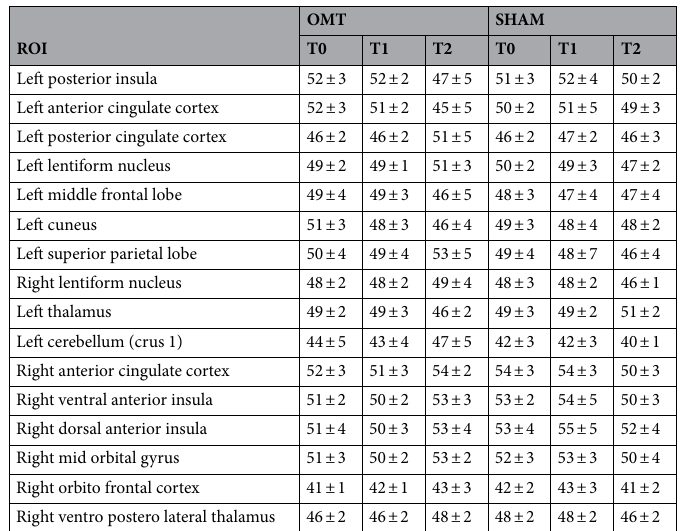
Table 2. rCBF values. Regional CBF values on region of interests (ROI) in both study groups at different time points. Values are expressed in ml/100 g/min. T0 baseline, T1 immediately after the first session, T2 at the end of the study